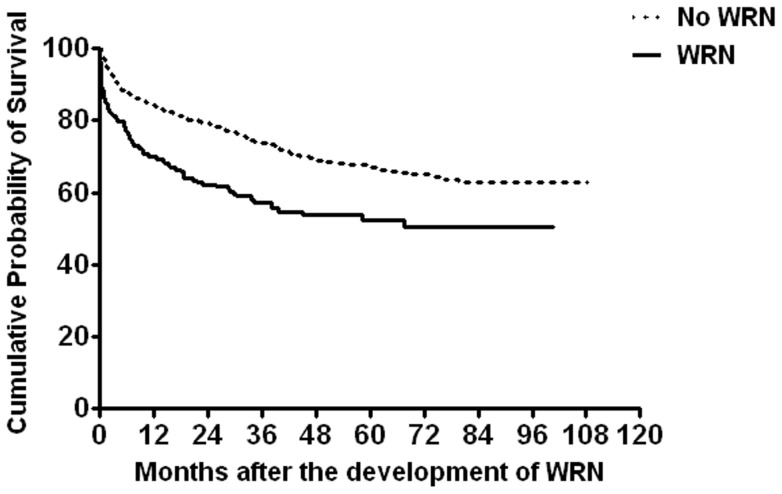
The impact of warfarin-related nephropathy on long-term mortality.Warfarin-related nephropathy significantly increased the mortality rate (p<0.001). The mortality rate was highest and survival difference between the two groups was greatest within 12 to 24 months after the occurrence of warfarin-related nephropathy, and decreased steadily and progressively over the time.